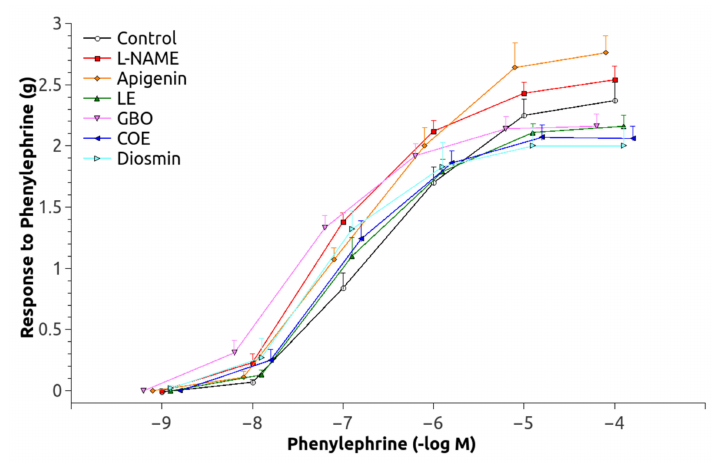
Figure 3. Pressor response to phenylephrine in aortic rings.